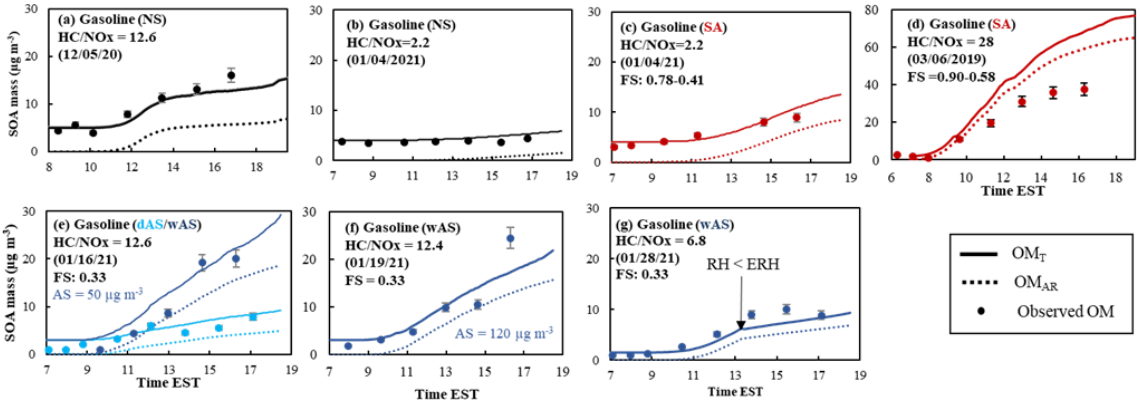
Figure 4. Observed (symbol) and simulated SOA mass using UNIPAR-CB6r3 (line) for the photooxidation of gasoline vapor at different NO x levels. SOA mass concentrations are corrected for the particle loss to the chamber wall. The simulated OM T (solid line) and OM AR (dotted line) are also illustrated. The error (9%) associated with SOA mass was estimated with the instrumental uncertainty in the OC/EC analyzer. SOA mass was produced via the photooxidation of gasoline vapor (Table 1) in the UF-APHOR chamber. The averaged deviations